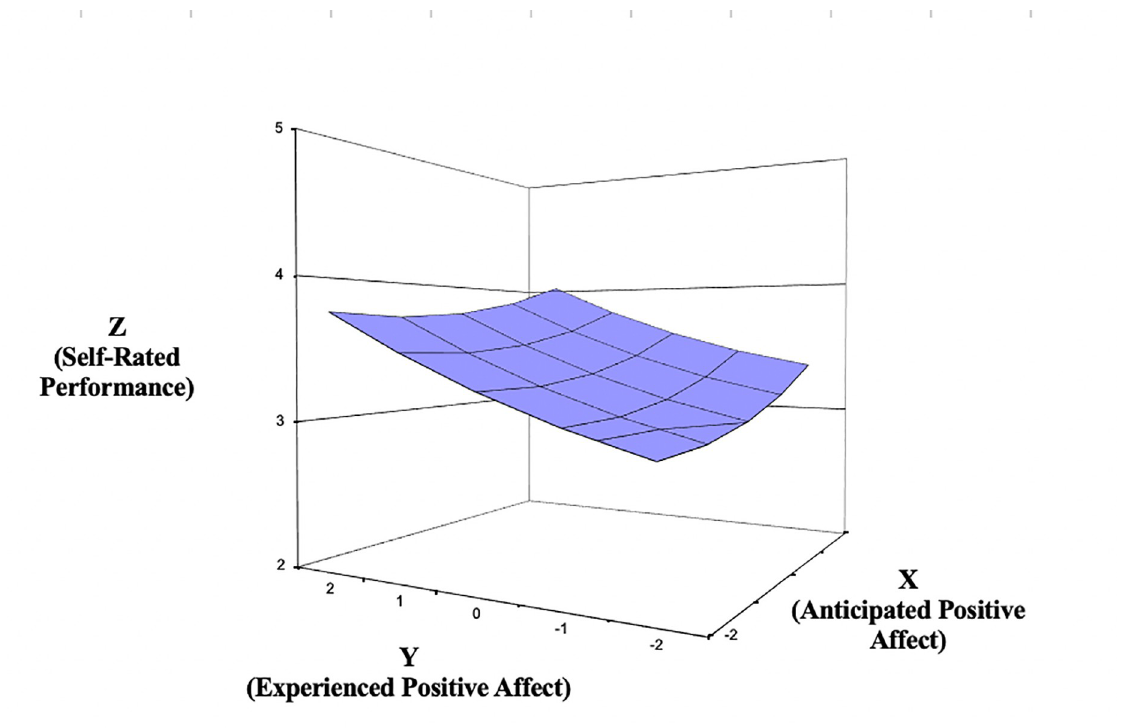
Fig 2. Response surface area wherein self-reported performance is predicted by the anticipated—experienced positive affect discrepancy (Study 1). Of note, when conducting polynomial regression, we scale-centered the predictors by subtracting the scale midpoint to reduce multicollinearity and aide interpretation. Each of the predictors evaluated in both studies were measured on a 5 point scale as noted in the Method sections; therefore we subtracted 3 from each predictor value, resulting in the values -2 to 2 in the along the X- and Y- axes in Figs 2–7. The variables on the Z- axes in Figs 2–7 are not centered and reflect the original 5-point Likert scale responses used (with the exception of time spent studying in study 2, which was assessed in